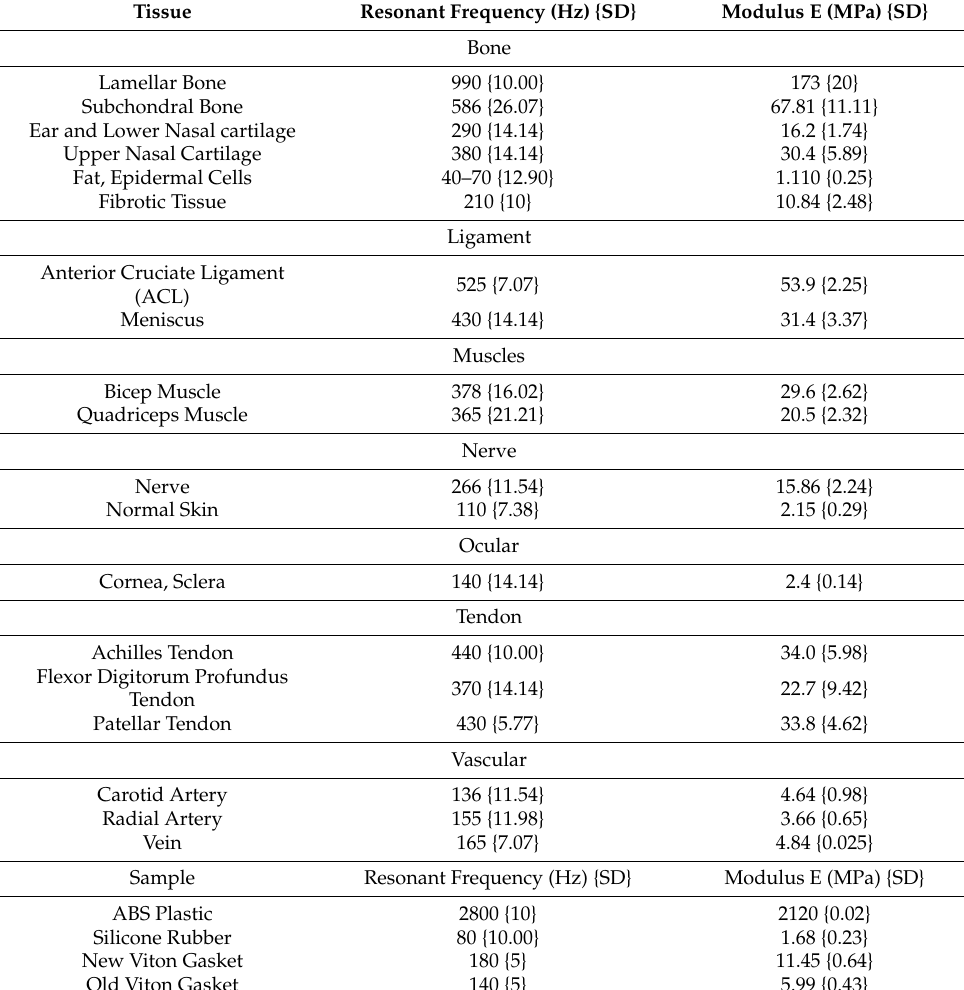
Table 1. Resonant frequency and modulus values for natural and synthetic polymers from [9]. Resonant frequencies (Hz), standard deviations (SD) and moduli (MPa) are determined from both in vivo and in vitro